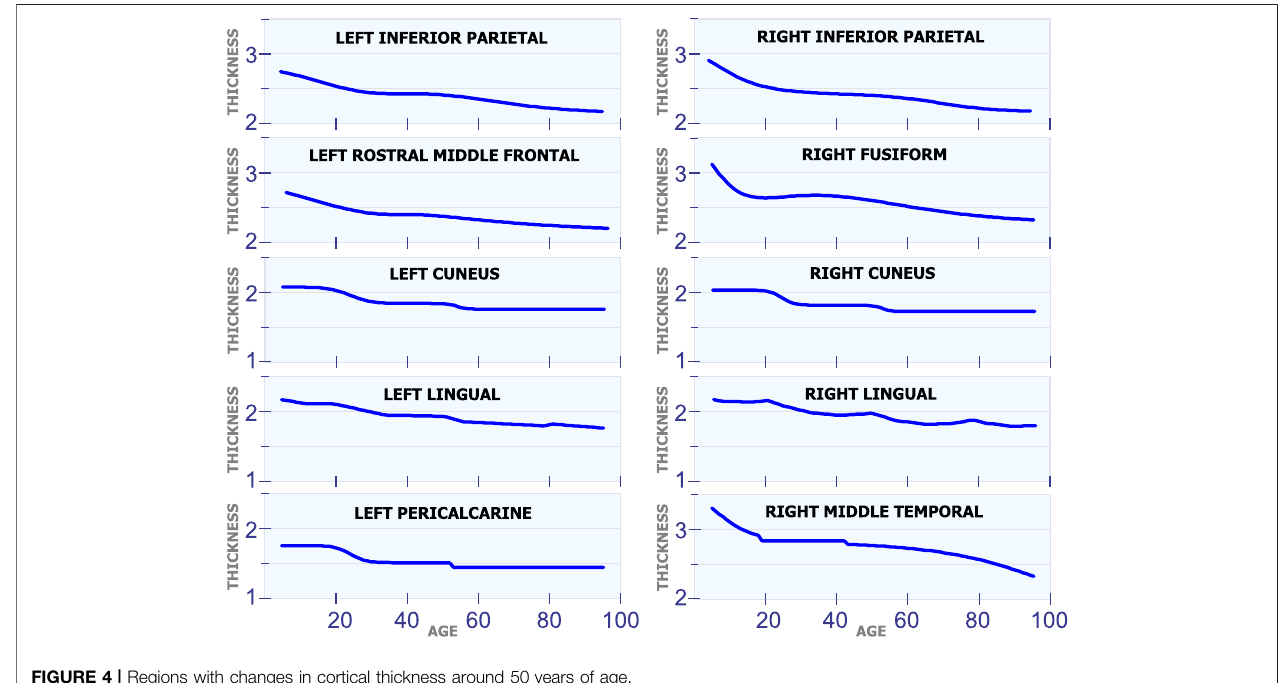
FIGURE 4 | Regions with changes in cortical thickness around 50 years of age.